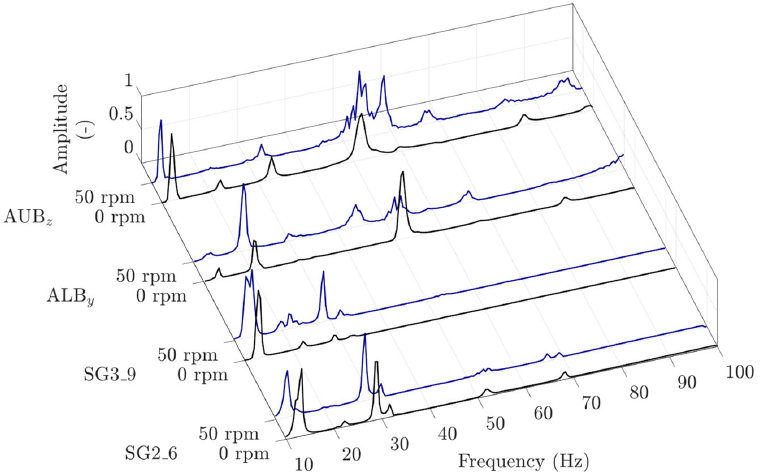
Figure 16. Maximum normalized spectra of the STFT measured from several sensors when the disk (non-rotating and rotating) was excited with a chirp in the range of 0–100 Hz in water.